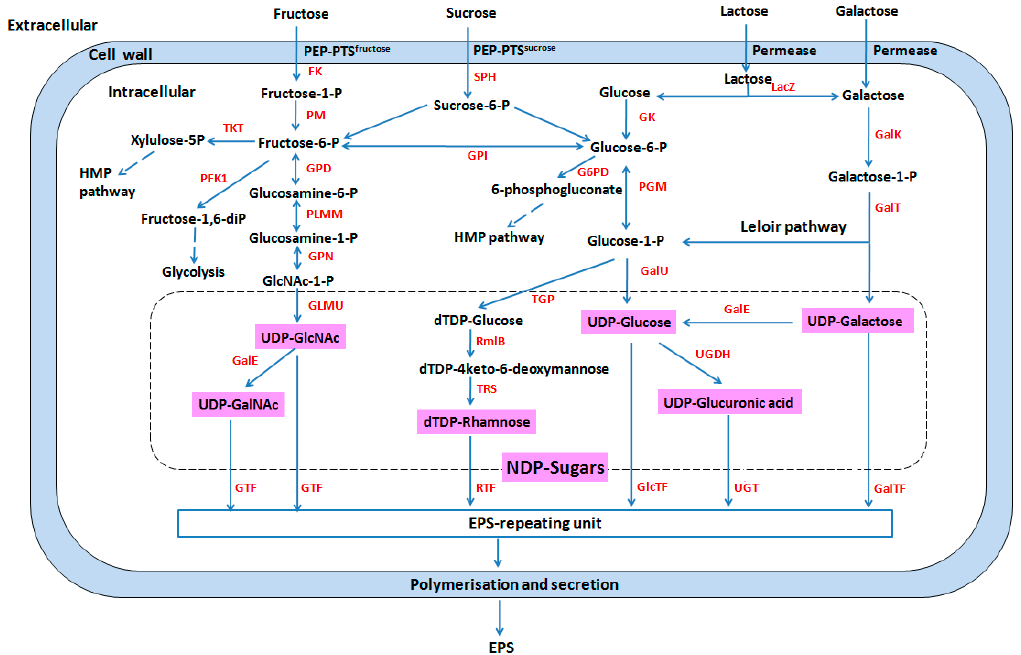
Figure 1. Pathways of sugar metabolism and exopolysaccharide (EPS) biosynthesis in S. thermophilus .